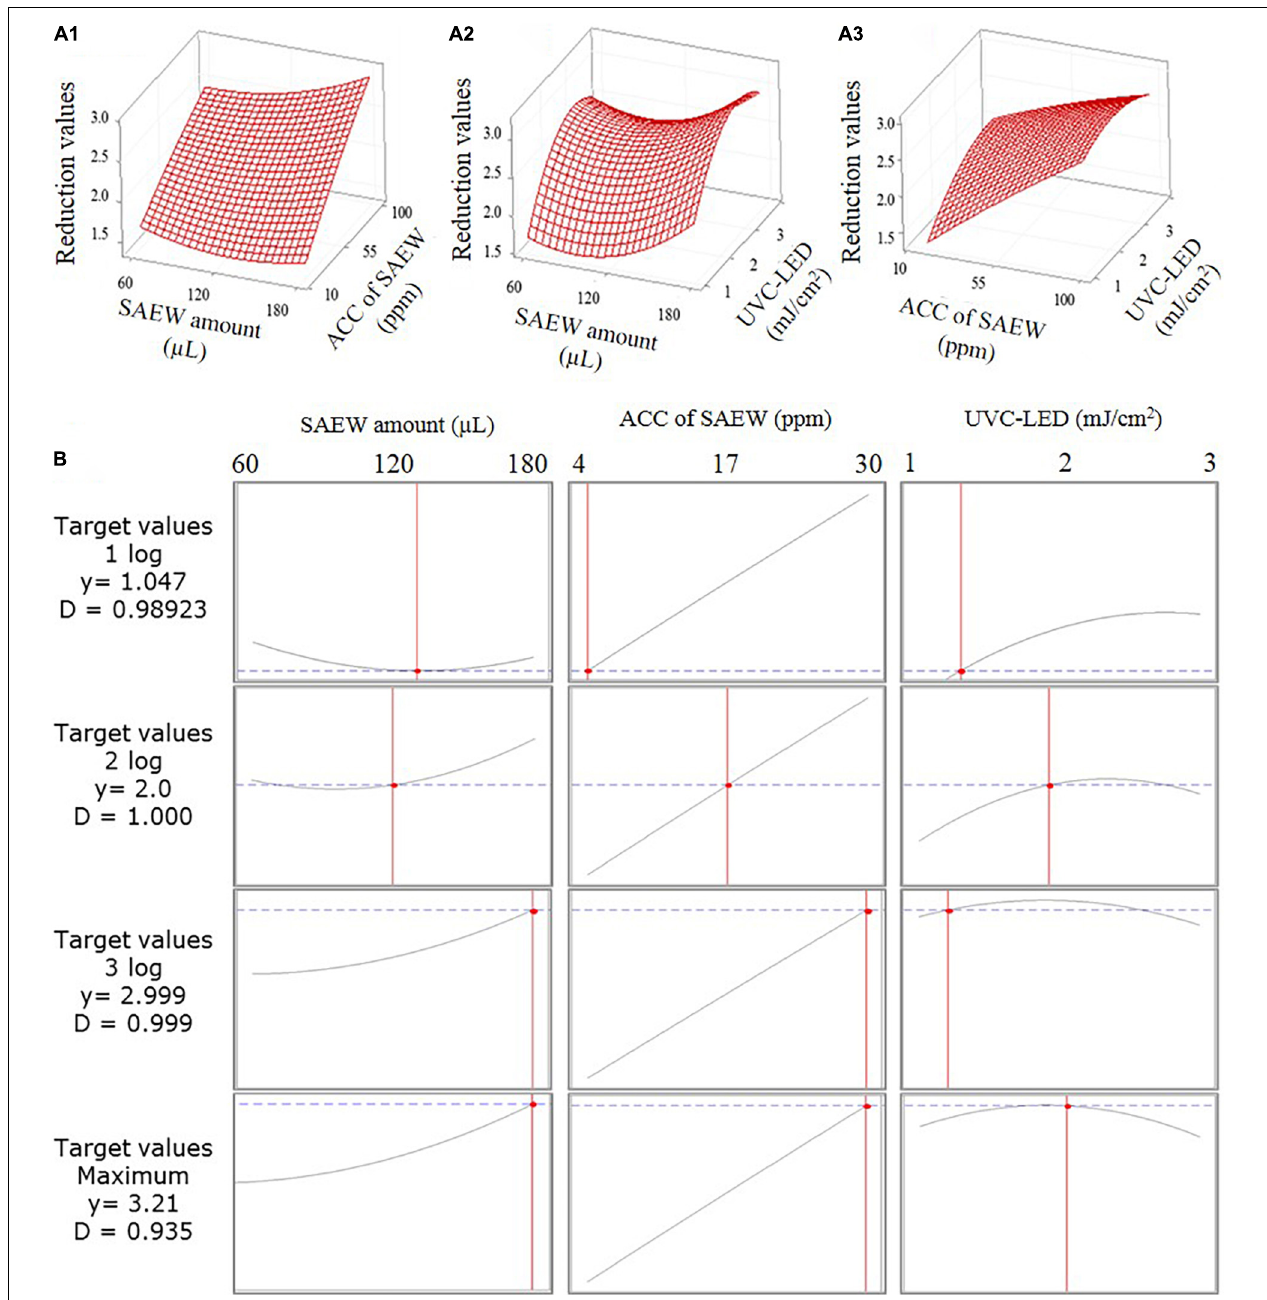
FIGURE 4 | 3-D response surface plots for the inactivation of human norovirus (HuNoV) using the combination of the sprayed slightly acidic electrolyzed water (SAEW) treatment and ultraviolet C light-emitting diode (UVC-LED) irradiation presenting the interaction between process parameters: (A1) SAEW concentration and SAEW amount, (A2) UVC-LED dose and SAEW amount, and (A3) UVC-LED dose and SAEW concentration. (B) Calculated optimizing plot using the MINITAB 19 software profile optimizer tool for combining the sprayed SAEW treatment and UVC-LED irradiation.